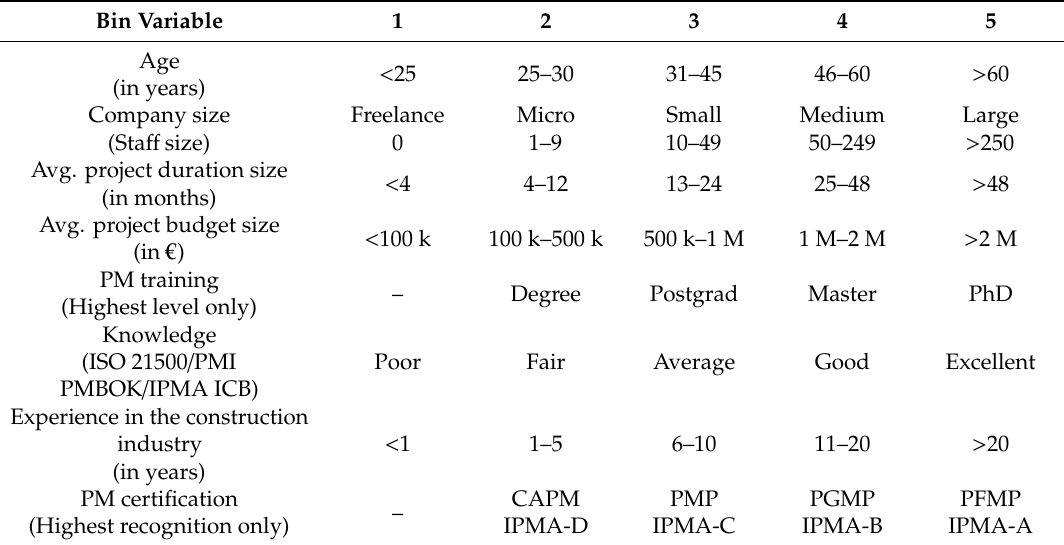
Table 6. Population demographic questions for sample